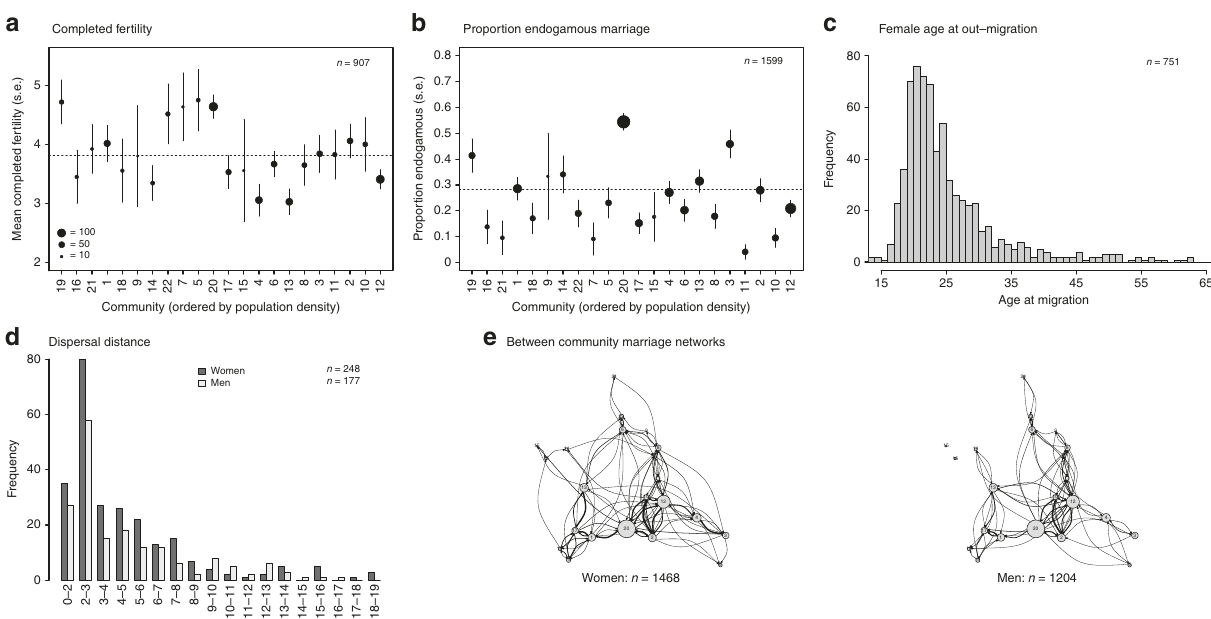
Fig. 1 Demography of the study communities. Between-community variation in a completed fertility (women aged 45 + ), and b proportion of endogamous marriages (means are indicated by dashed lines); c age at out-migration for women; d frequency distribution of distances between natal and post-marital residence for men and women, and e marriage connections between communities for women (left) and men (right). Communities in a , b are ordered from left to right by increasing population density. Communities in (e) are shown in relative geographic space: edge width indicates the frequency of people moving to a particular community after marriage. Data are provided in a Source Data fi